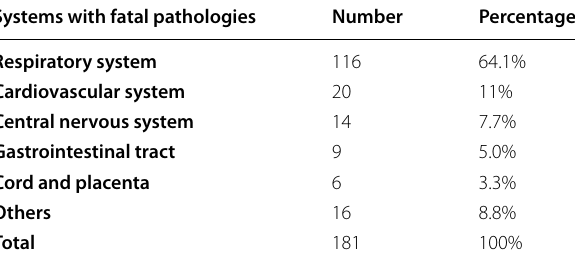
Table 5 Cause of explained death in autopsied children who died suddenly without any prodrome ( n Cause of unexpected death without